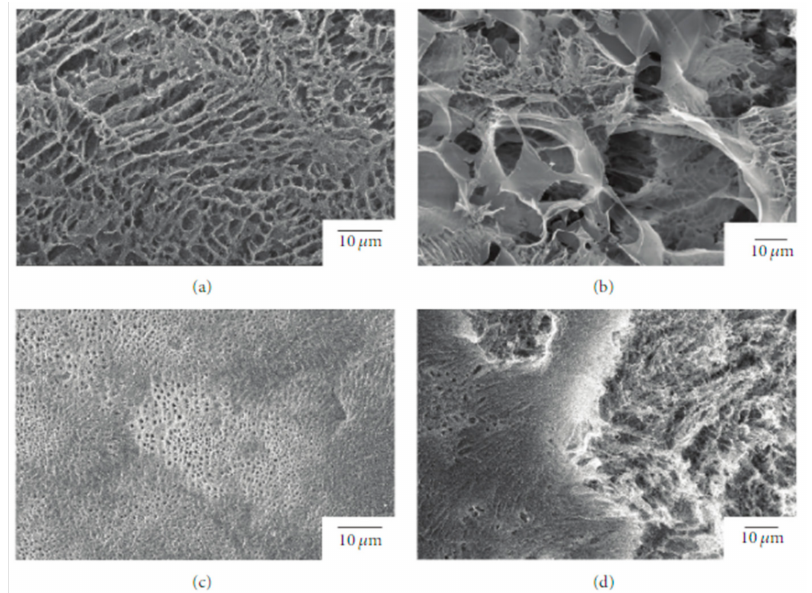
Figure 3. SEM images of the surface and interior of PLLA/rifampicin blend particles prepared by the drop freeze-drying method. ( a ) PLLA = 2.0 wt%, surface, ( b ) PLLA = 2.0 wt%, interior, ( c ) PLLA = 4.9 wt%, surface, and ( d ) PLLA = 4.9 wt%, interior. Reprinted with permission from Hindawi